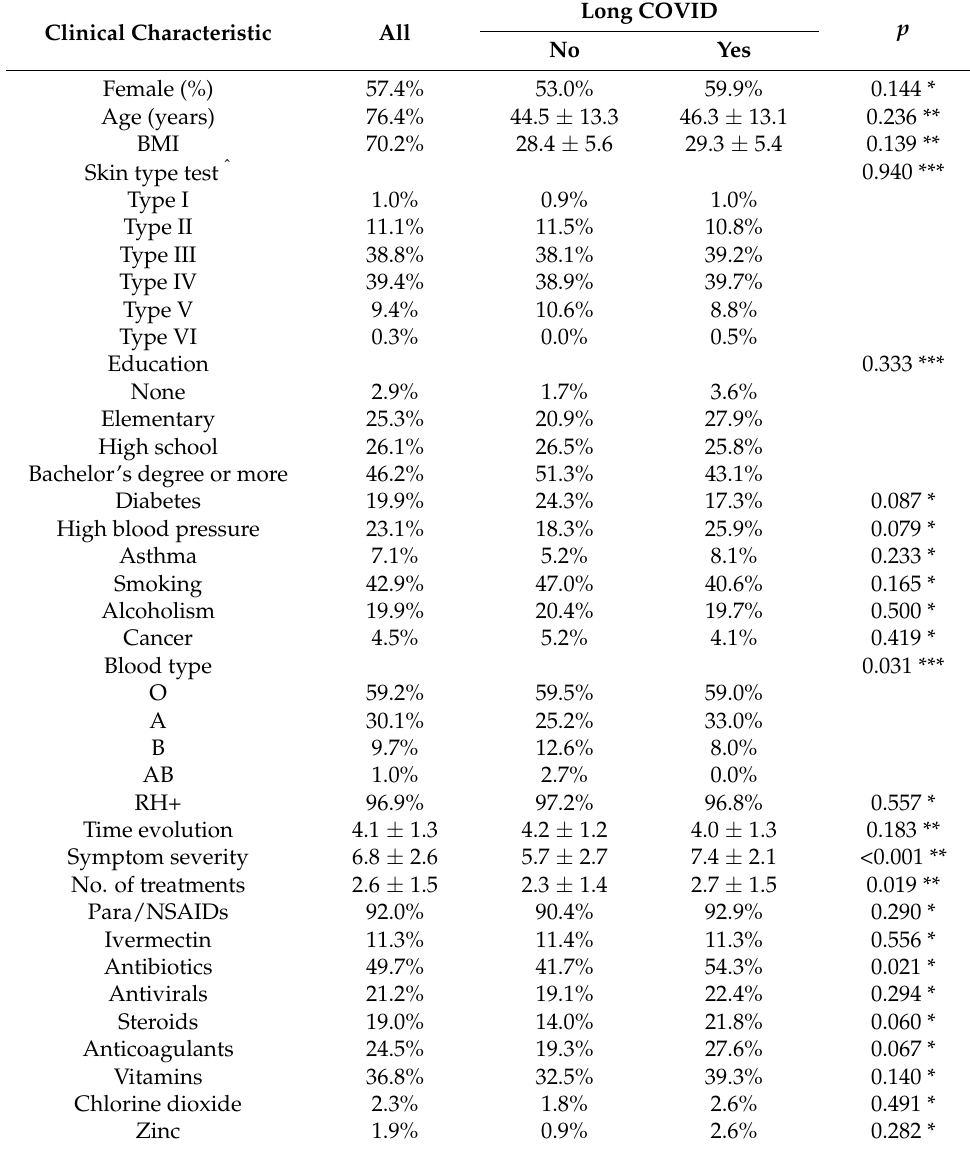
Table 2. Main clinical characteristics of the participating subjects at the time of enrollment and prescribed